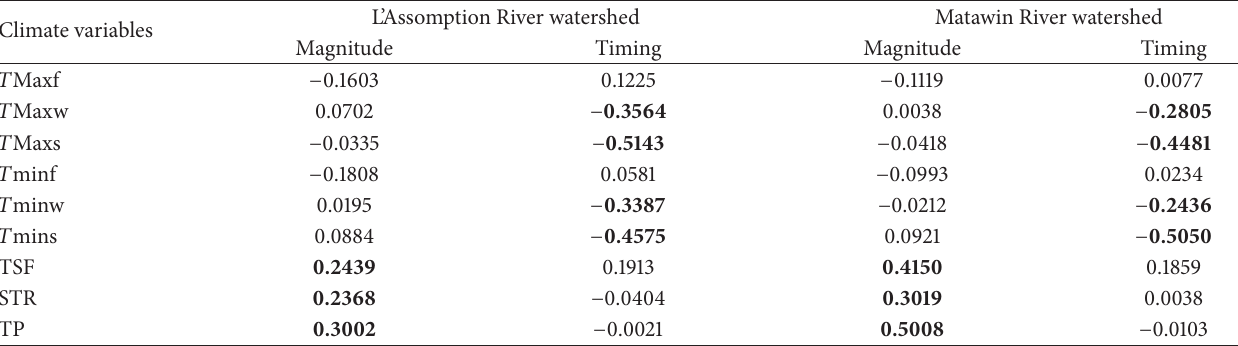
Table 4: Correlation coefficients calculated between climate variables and characteristics (magnitude and timing) of maximum spring flows